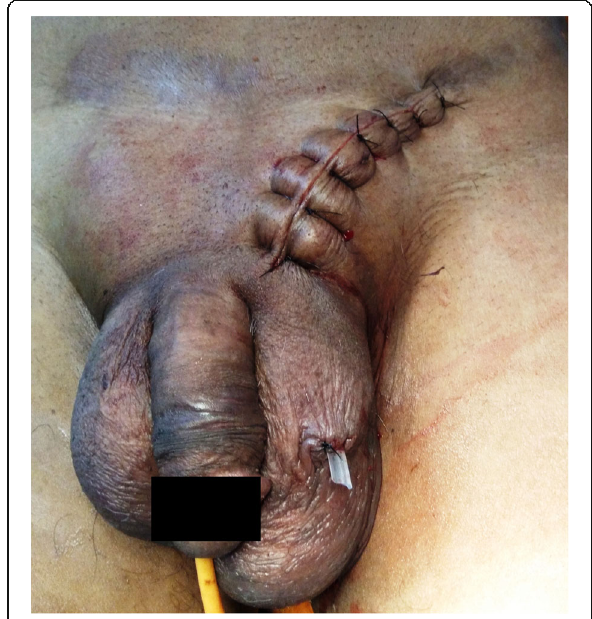
chest pain, tachycardia, and tachypnea in post-op period. BP was normal throughout the post-operative